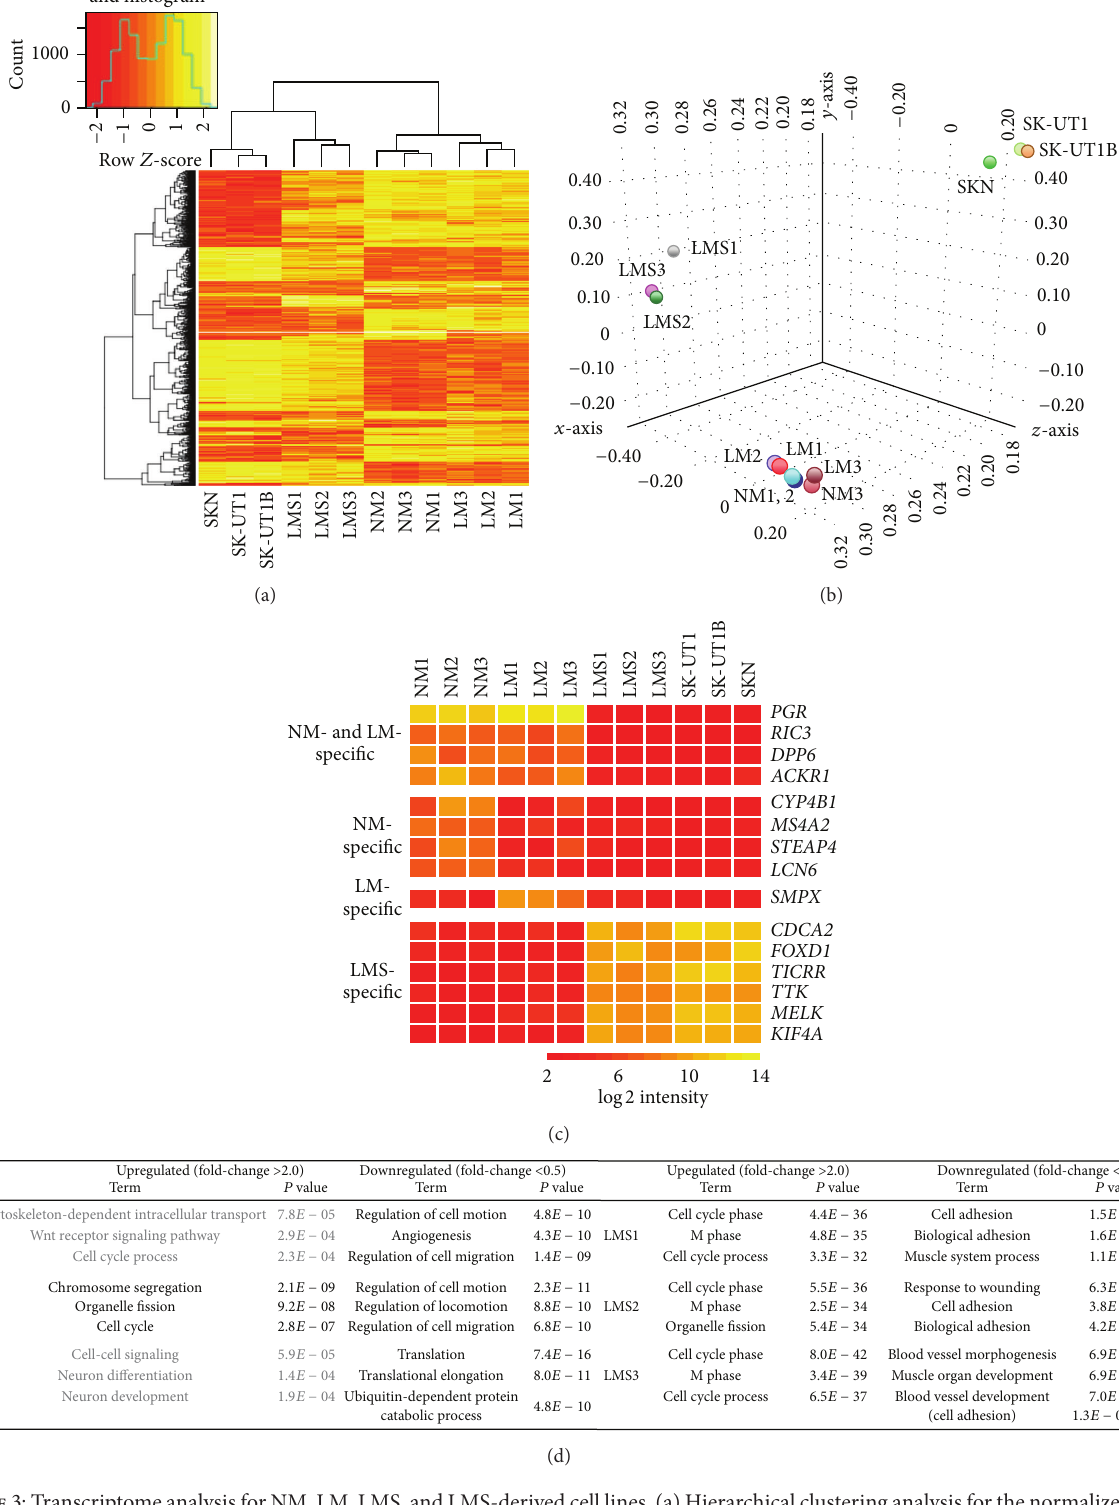
Figure 3: Transcriptome analysis for NM, LM, LMS, and LMS-derived cell lines. (a) Hierarchical clustering analysis for the normalized log 2 - transformed intensities of the 1,036 differentially expressed genes using Heatmap2. (b) Three-dimensional visualization of PCA for the entire probe set. (c) Candidate expression markers. Of the 45 LMS-specific genes selected, only six, whose log 2 intensities in LMS and LMS-derived cell lines are > 9, are shown (full genes are shown in Supplementary Material, Table S3). (d) GO analysis for up- and downregulated genes in each of the LM and LMS samples. The top three GO terms of biological process and their 𝑃 values are shown in black when the corresponding Benjamini’s corrected 𝑃 value was < 0.05 or are otherwise shown in